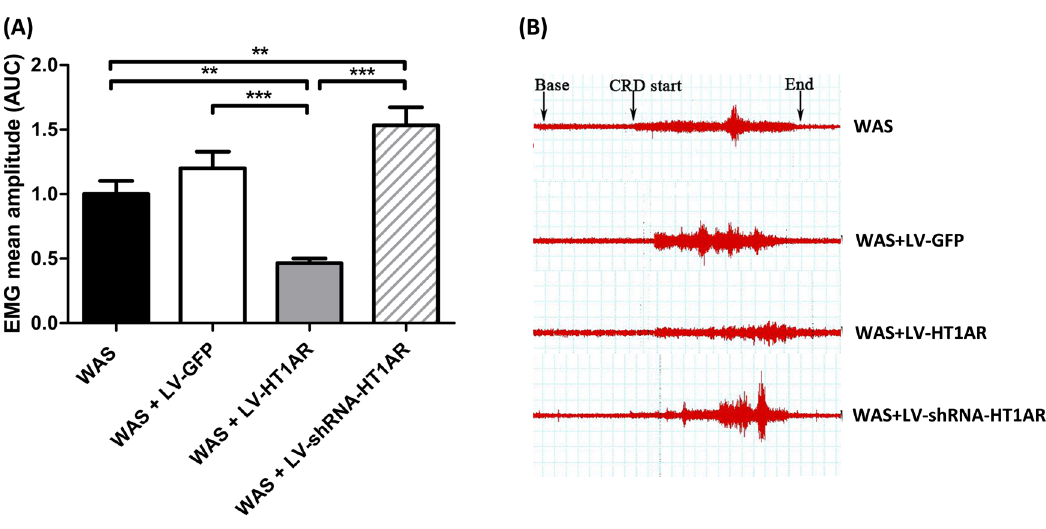
Figure 1: Effects of bilateral ACC lentivirus intervention on VMR. Mean amplitude of the visceromotor response (VMR) is expressed as the area under the curve (AUC) after baseline subtraction. Amplitudes of VMR to 60mmHg CRD were compared among WAS, WAS+LV-GFP, WAS+LV-HTR1A and WAS+LV-shRNA-HTR1A groups (A). Results were collected from ten rats in each group. (B) VMR to 60mmHg CRD